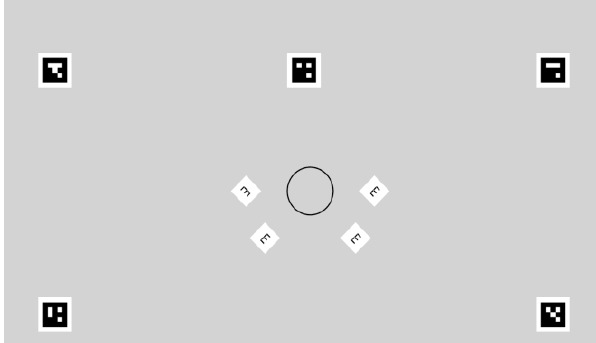
Figure 4. Screen capture from the control task. The fixation circle and target presentation were the same as in the steering task, but the road view was not visible and the participant did not actively steer. The horizontal movement of the fixation circle and target position dis- play corresponded to the movement produced by a path following the road centre (in fact movement of the vehi- cle was simulated behind the scenes). The square screen markers around the edges were used to detect the screen from the image of the eye tracker's front camera and determine a transformation from the camera coordinates to the screen